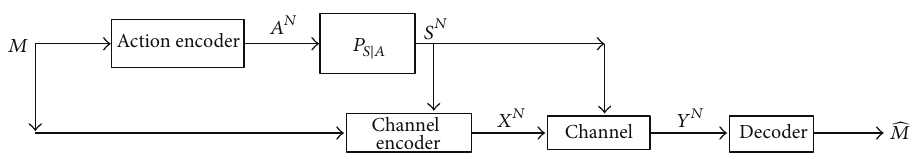
Figure 4: Channel with action-dependent states.